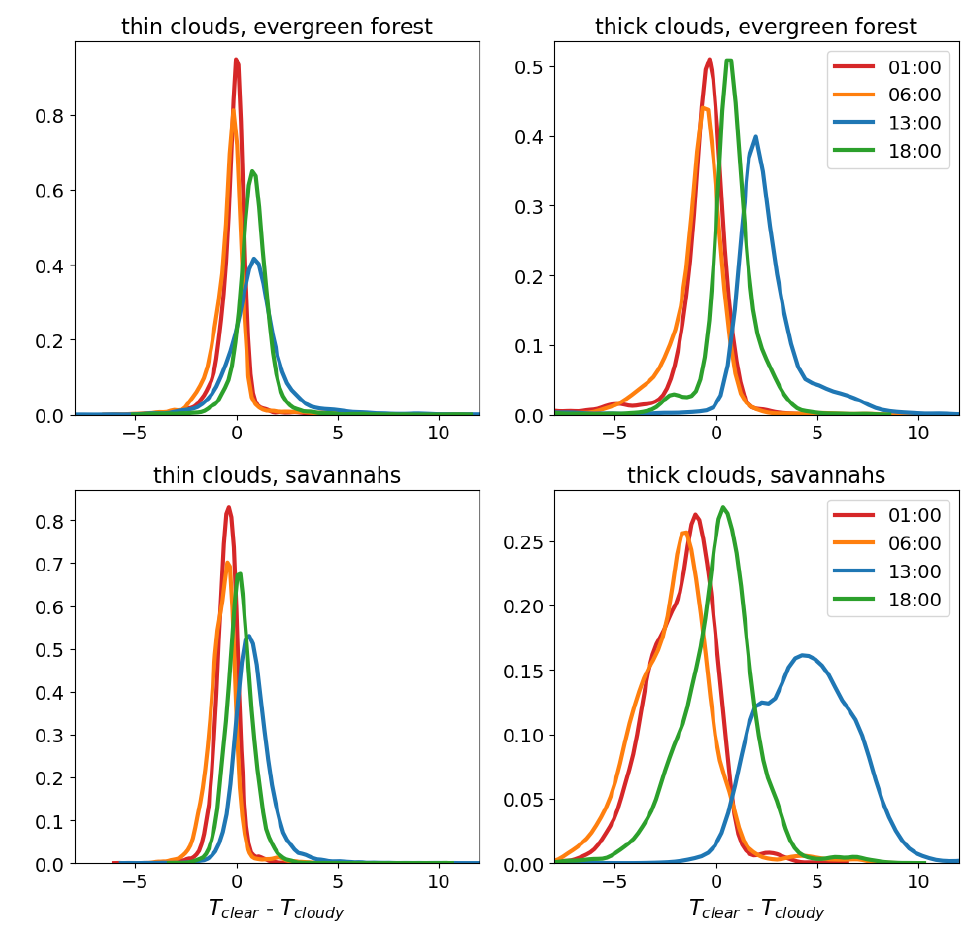
Figure 4. Distribution of ∆ T , i.e., surface-temperature difference, from ERA5 data in January, May, and September 2016. The difference is computed between clear and thin clouds ( TCLW < 50 g/m 2 ) on the first columns, and between clear and thick clouds ( TCLW > 50 g/m 2 ). The first row